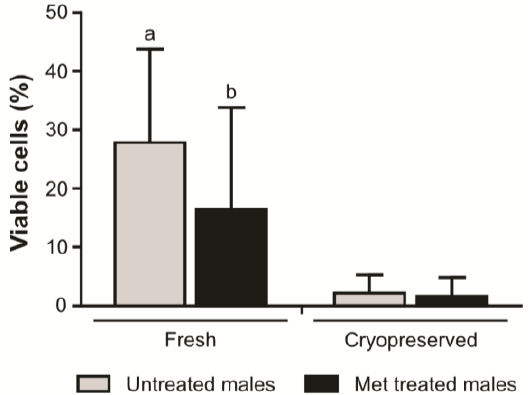
Figure 3. Spermatozoa plasma membrane viability of fresh and cryopreserved sperm from untreated Tg( ins : nfsb-mCherry ) males ( n = 5) and metronidazole (Met)-treated males ( n = 6). The plotted values represent means ± SD. Different superscript letters represent statistical differences (independent samples t -test, p < 0.05).